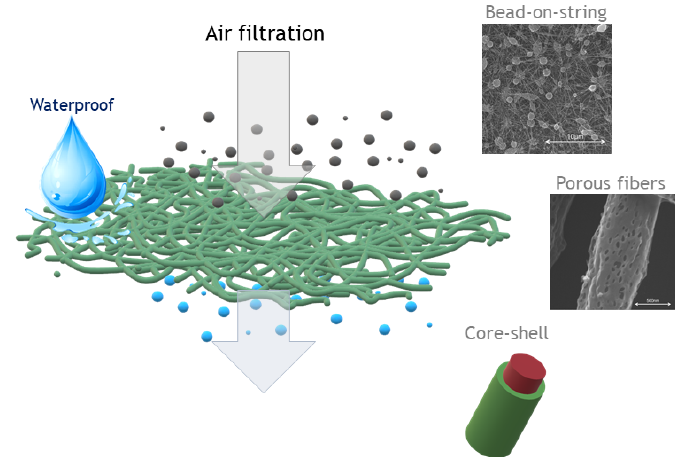
Figure 5. Scheme of a waterproof membrane suitable for air filtration/bio-filtration thanks to its structural features. Examples of structures and morphologies obtained by Electro Fluid Dynamic techniques: bead-on-string, porous and core/shell nanofibers.